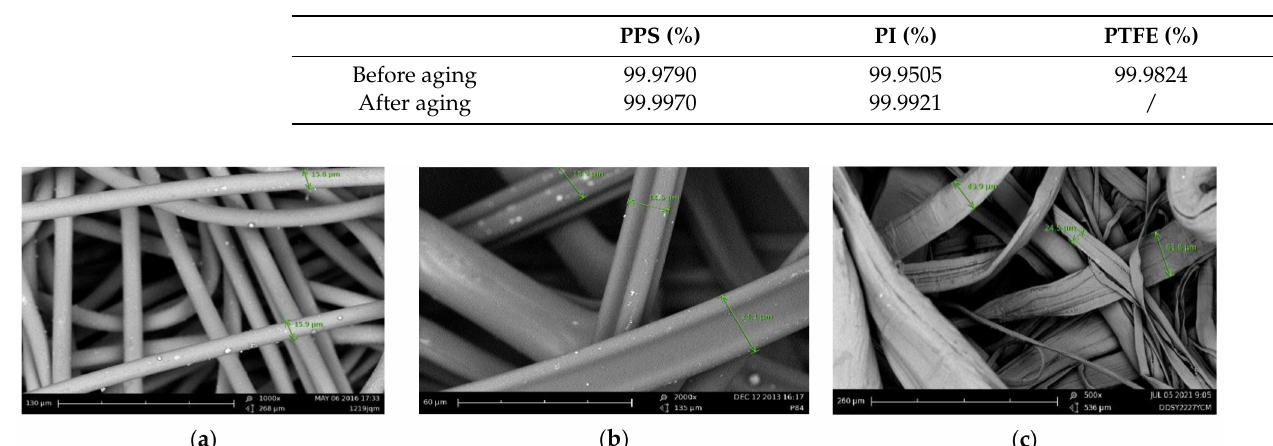
Table 3. Filtration efficiency of different material filtration materials.